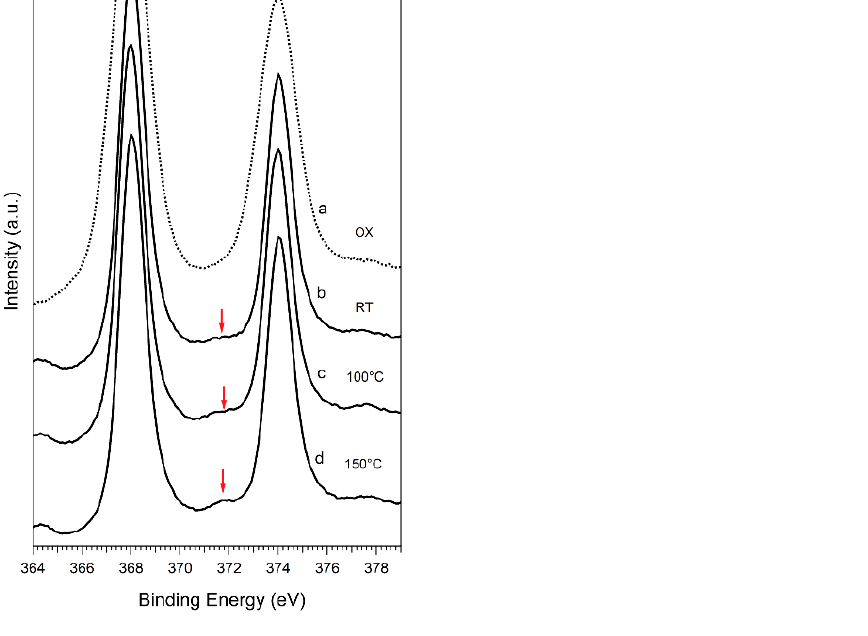
Figure 6. ( a ) Optical loss spectra of Ag/MgO NPs at different coverages levels. ( b ) Differential optical loss spectra of sam ‐ ples with different coverages of Ag/MgO NPs. The differences in signal intensity of L sub (and therefore the corresponding L) for different samples may arise from small variations in contaminants (e.g., carbon), humidity and roughness. ( c ) The imaginary part of the calculated in ‐ plane polarizability for Ag NPs having different aspect ratios embedded in a MgO matrix with refractive index n = 1.7. ( d ) The imaginary part of the calculated in ‐ plane polarizability for Ag NPs having